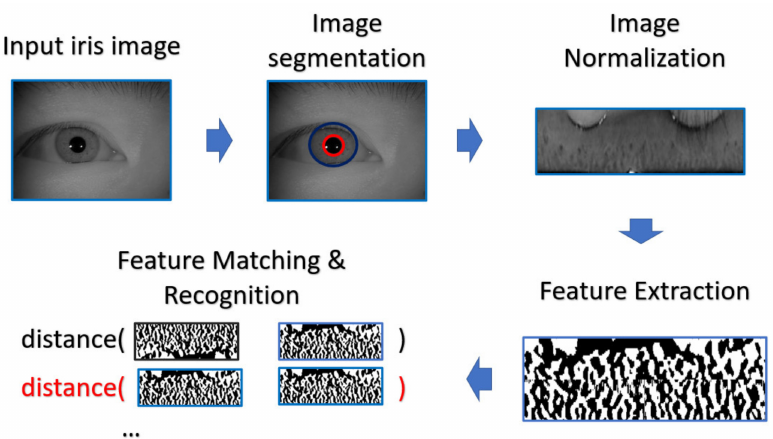
Figure 10. The flowchart of iris recognition in our